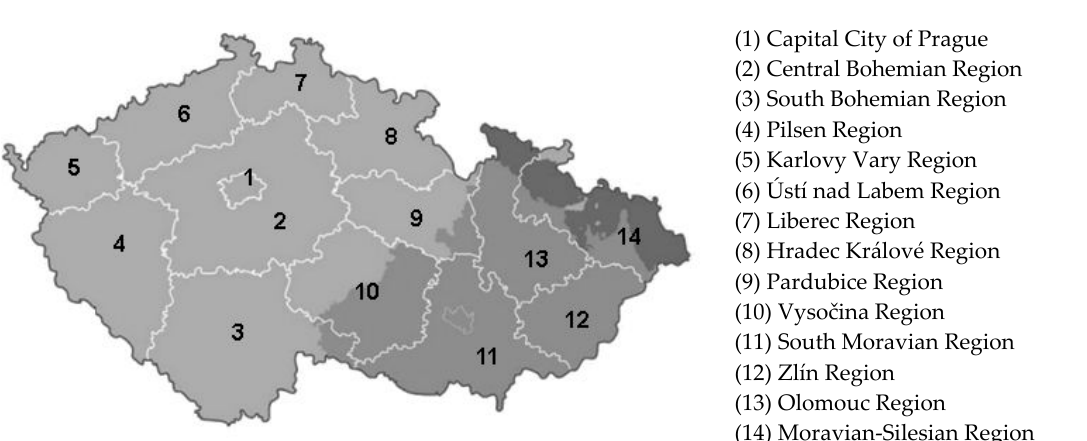
Figure A1. Administrative division of Czechia. Source: Czech Statistical Office. Note: Light grey: Bohemia; Grey: Moravia; Dark grey: Silesia.